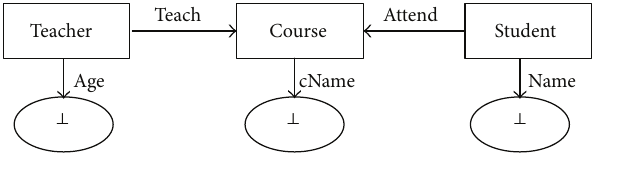
Figure 2: A W-schema 𝑆 of 𝐼 .